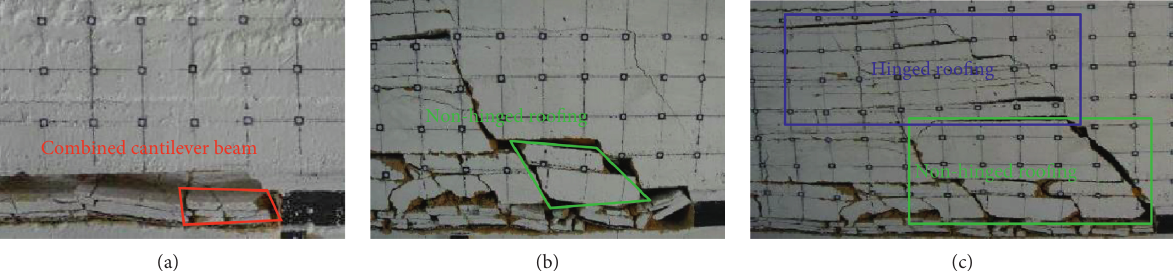
Figure 2: Damage mode of overlying rock during the advancement of working face. (a) Working face advanced to 20m;(b) working face advanced to 70m; (c) working face advanced to 120m.